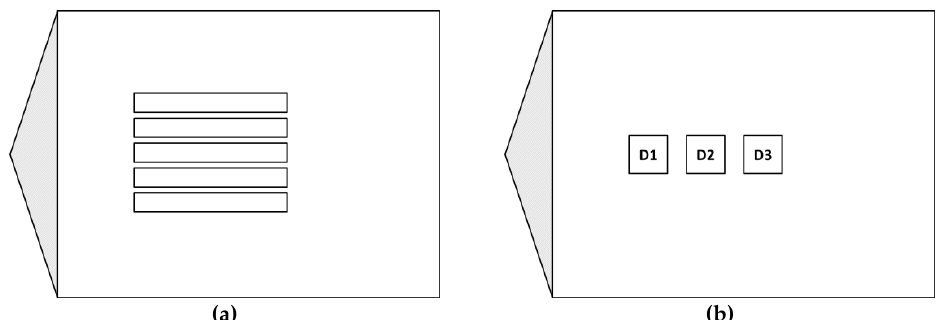
Figure 1. Plate geometry used for the physical foaming trials. Blue dots indicate injection points.